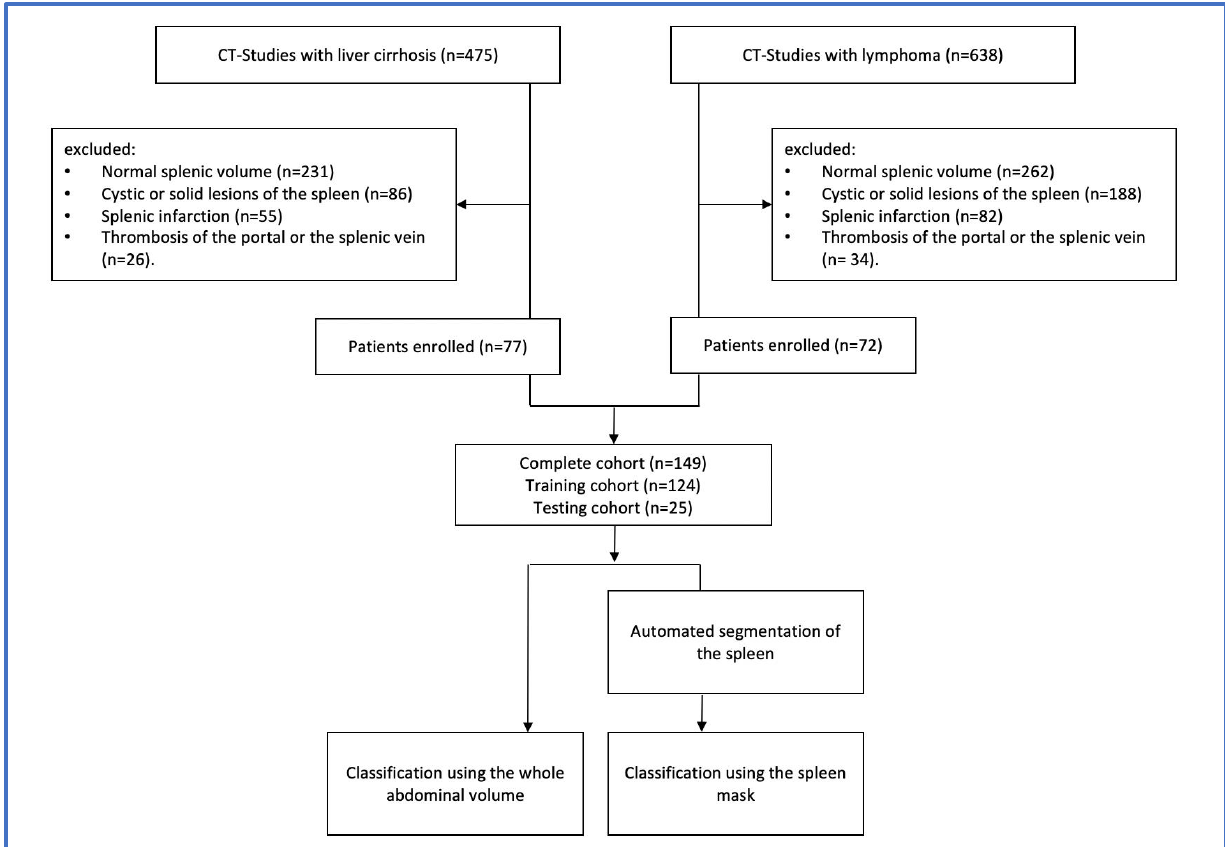
Figure 1. Study flow diagram showing the steps conducted for the selection of samples and the study design.